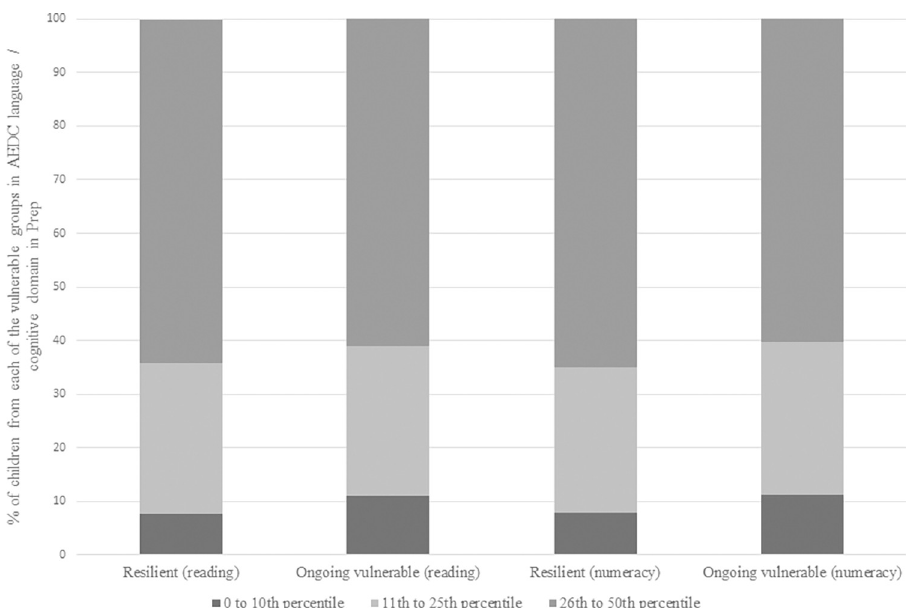
Fig 2. AEDC language/cognitive domain at school entry. Percentages of children from each of the vulnerable groups in Prep language/cognitive domain (AEDC), identified as resilient or ongoing vulnerable in each of reading and numeracy in Grade